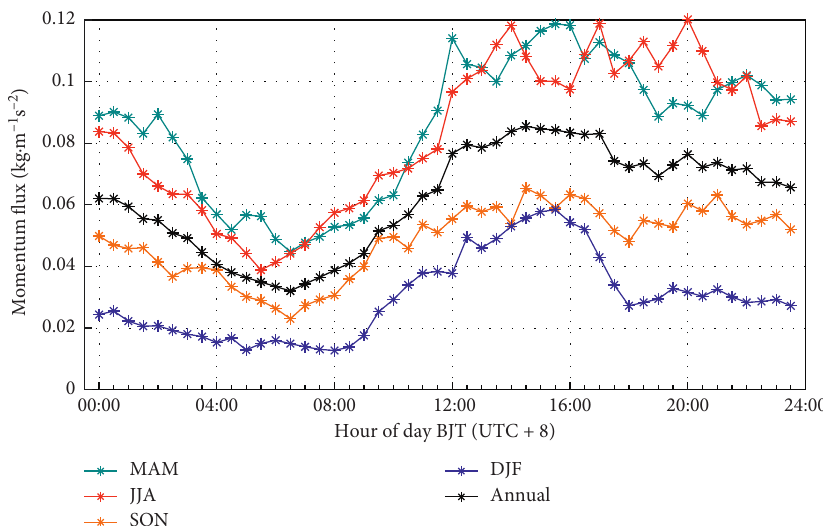
Figure 5: Diurnal variation of turbulent momentum fluxes.